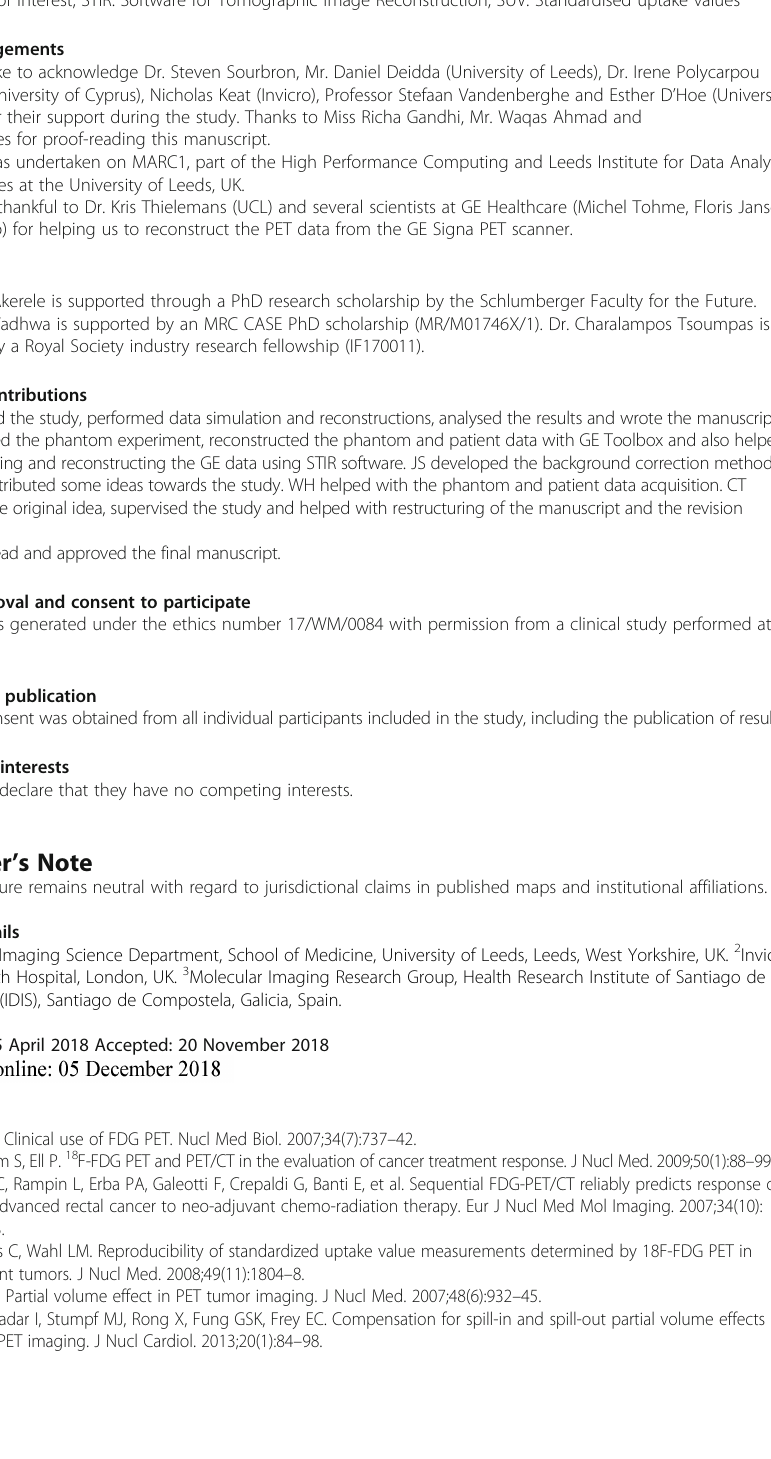
reconstructions. Figure S6. Normalised mean values within the dilated shells surrounding the spleen obtained with non-TOF and TOF reconstructions at (a) 3 iterations and (b) 20 iterations. Table S1. This shows how bladder SUV affects lesion quantification for each lesion diameter. This is expressed as the % change in lesion SUV as bladder SUV increases. The SUV values are the mean values from all noise realisations at 30 full iterations with 4 mm post-filter. (DOCX 139 kb) Abbreviations 68 Ga-PSMA: Prostate-specific membrane antigen labelled with 68 Ga; BC: Background Correction; CNR: Contrast-to-noise ratio; FOV: Field of view; FWHM: Full width at half maximum; GE: General Electric; IQ: Image quality; OSEM: Ordered subset expectation maximisation; PET: Positron emission tomography; PSF: Point-spread function; RD: Ring difference; ROI: Region of interest; STIR: Software for Tomographic Image Reconstruction; SUV: Standardised uptake